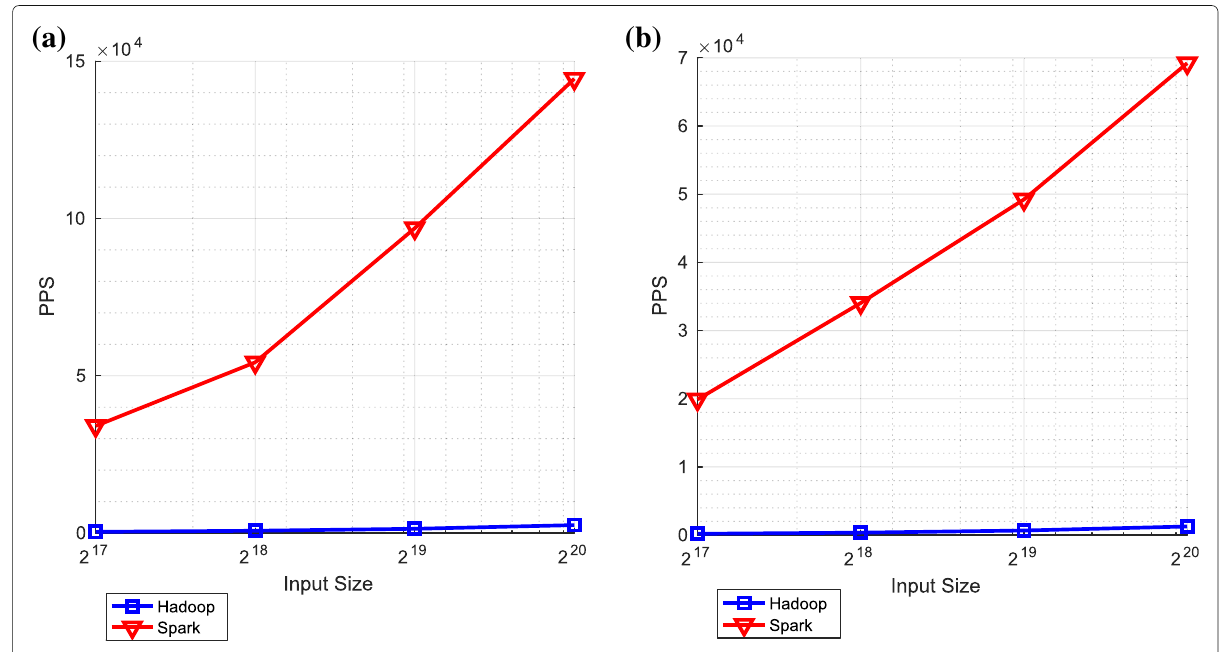
Fig. 9 Summation and cumulative summation on Spark and Hadoop. a Summation. b Cummulative summation